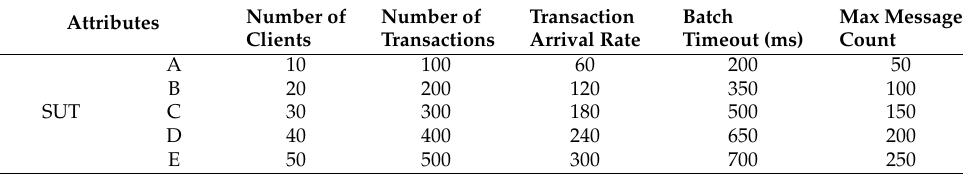
Table 6. System under test performance attributes in our